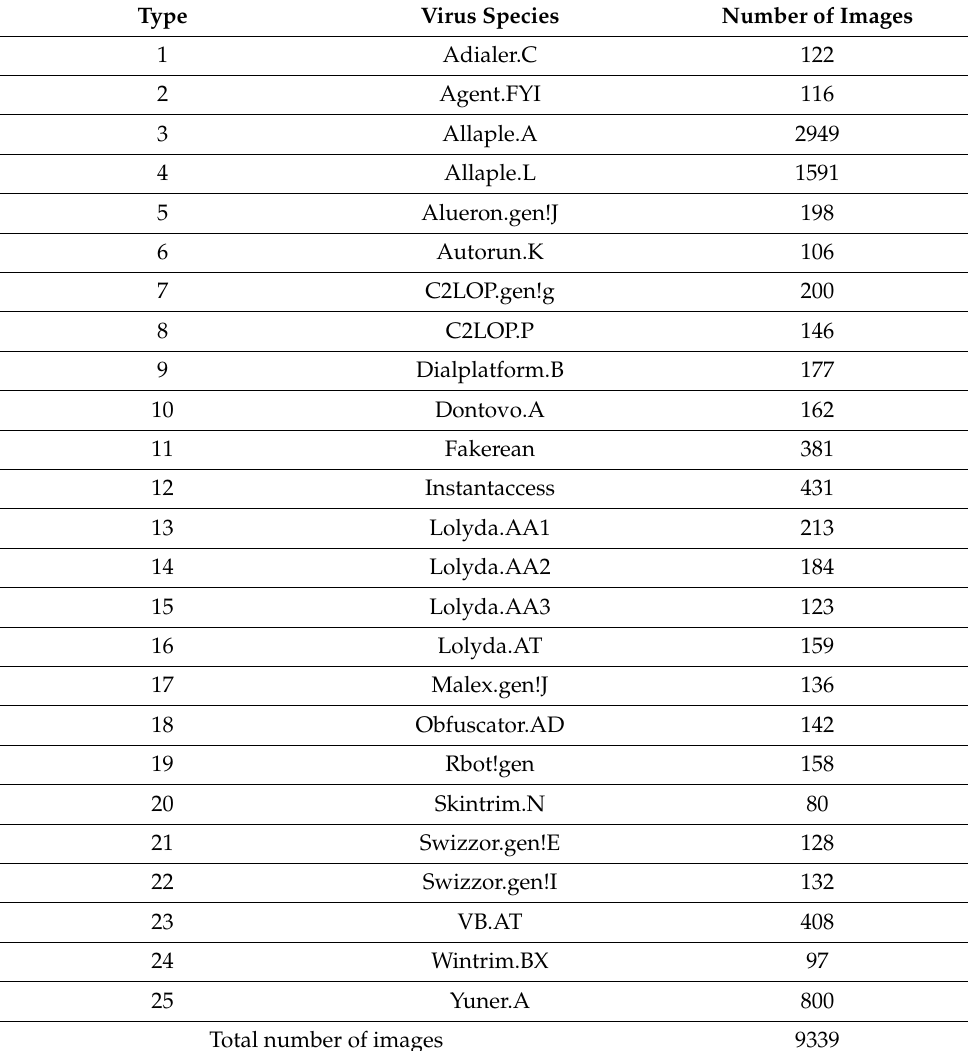
Table 1. Numbers of images of various types of viruses adopted in this study